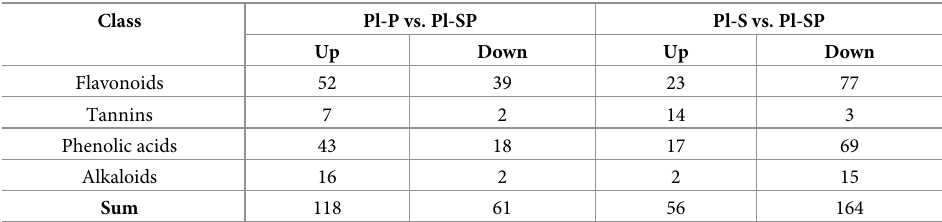
Table 1. Statistics of the DAMs with putative antioxidant in comparison